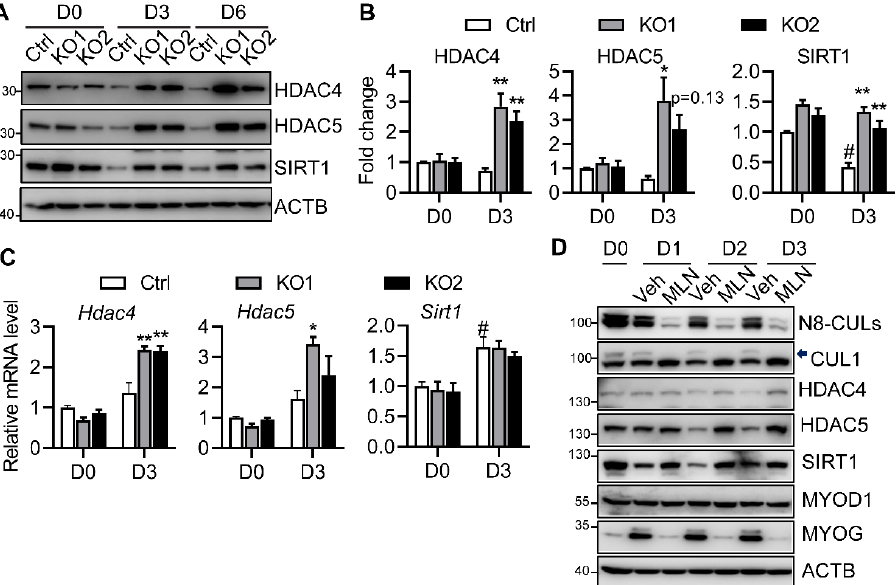
Figure 4. Neddylation controls the expression of class IIa and class III HDACs during myoblast differentiation. ( A ) Western blots of HDAC4, 5 and SIRT1 in NAE1-KO C2C12 cells before (D0) and after 3 and 6 days (D3 and D6) of myoblast differentiation as compared with vector controls (Ctrl). ( B ) Protein expressions at D0 and D3 were quantified by normalizing to ACTB. Data were presented as fold changes with D0 Ctrl cells set at 1. ( C ) qRT-PCR gene expression analysis of Hdac4/5 and Sirt1 at D0 and D3 of myoblast differentiation. D0 Ctrl cells were set at 1. * p < 0.05; ** p < 0.005 vs. Ctrl at the same day of differentiation. # p < 0.05 vs. D0 Ctrl cells. Two independent experiments in triplicates. ( D ) Western blots of neddylated Cullins (N8-CULs), CUL1, HDAC4, 5, and SIRT1, and myogenic transcription factors in vehicle (Veh) and 0.5 μ M MLN4924 (MLN) treated C2C12 cells before and during the first three days of myogenic differentiation. Arrow indicates neddylated CUL1. Three independent experiments.